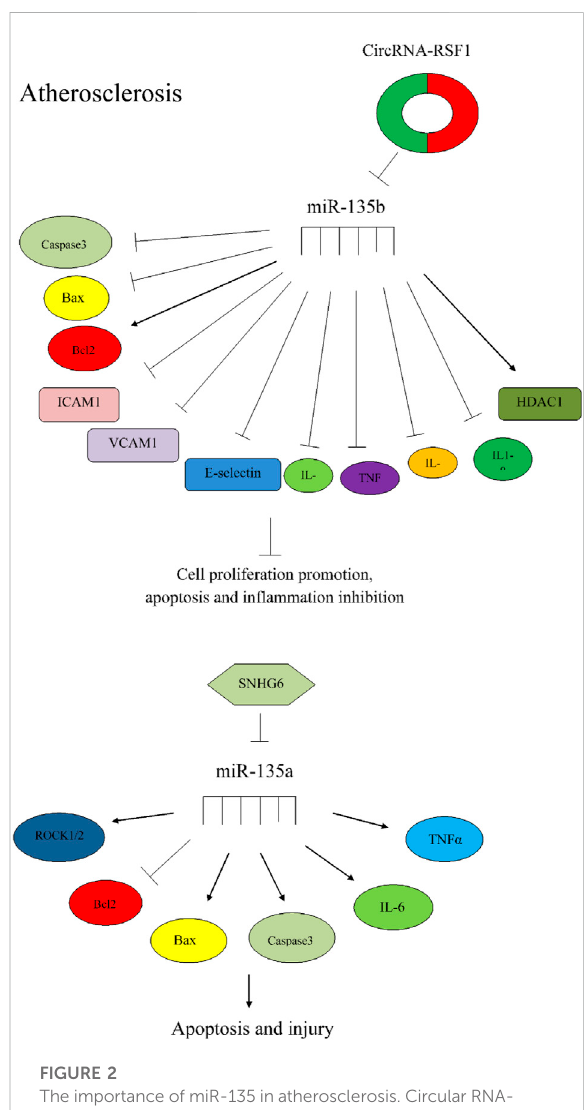
FIGURE 2 The importance of miR-135 in atherosclerosis. Circular RNA- RSF1 could promote proliferation of vascular endothelial cells and prevent apoptosis and in fl ammation via regulation of